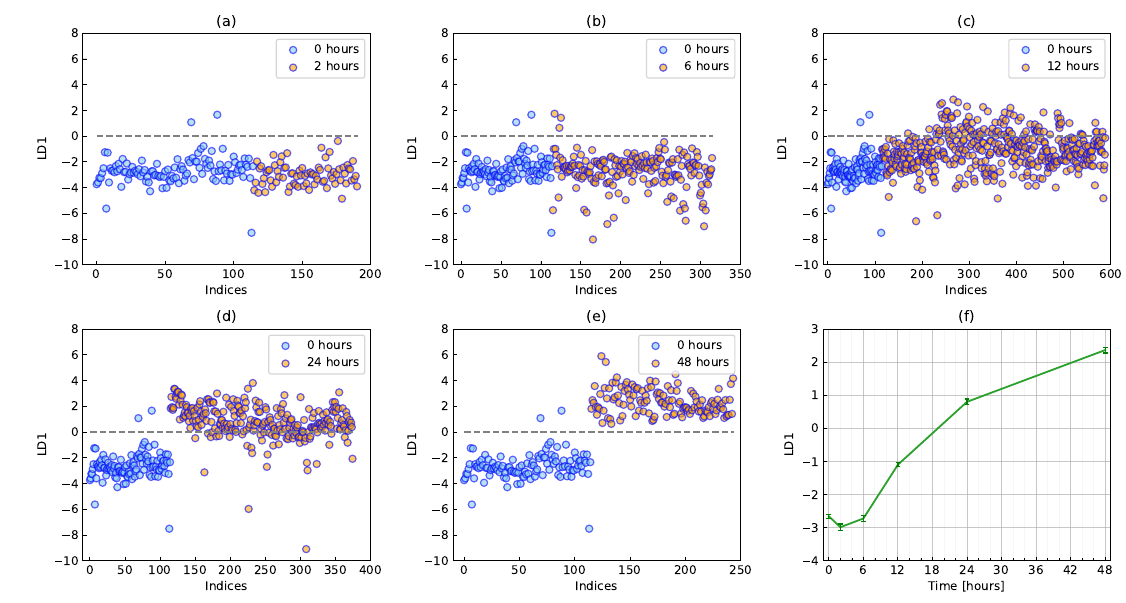
Figure 3. Classification of naïve and activation states by PCA-LDA. Scatter plots of discriminant scores at ( a ) 2, ( b ) 6, ( c ) 12, ( d ) 24 and ( e ) 48 h together with the naïve state at 0 h. Red circles show cells at each time point together with blue circles at 0 h. ( f ) Time evolution of the average discriminant score during T cell activation. Error bars show the standard